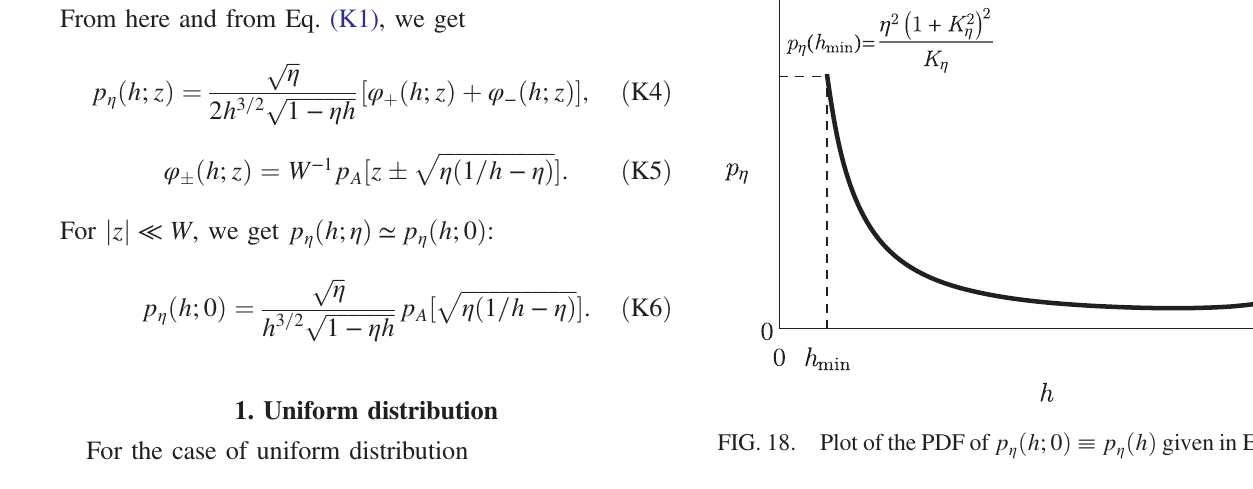
ffiffiffiffiffiffiffiffiffiffiffiffiffiffiffiffiffiffiffiffiffi p η ð 1 =h − η Þ